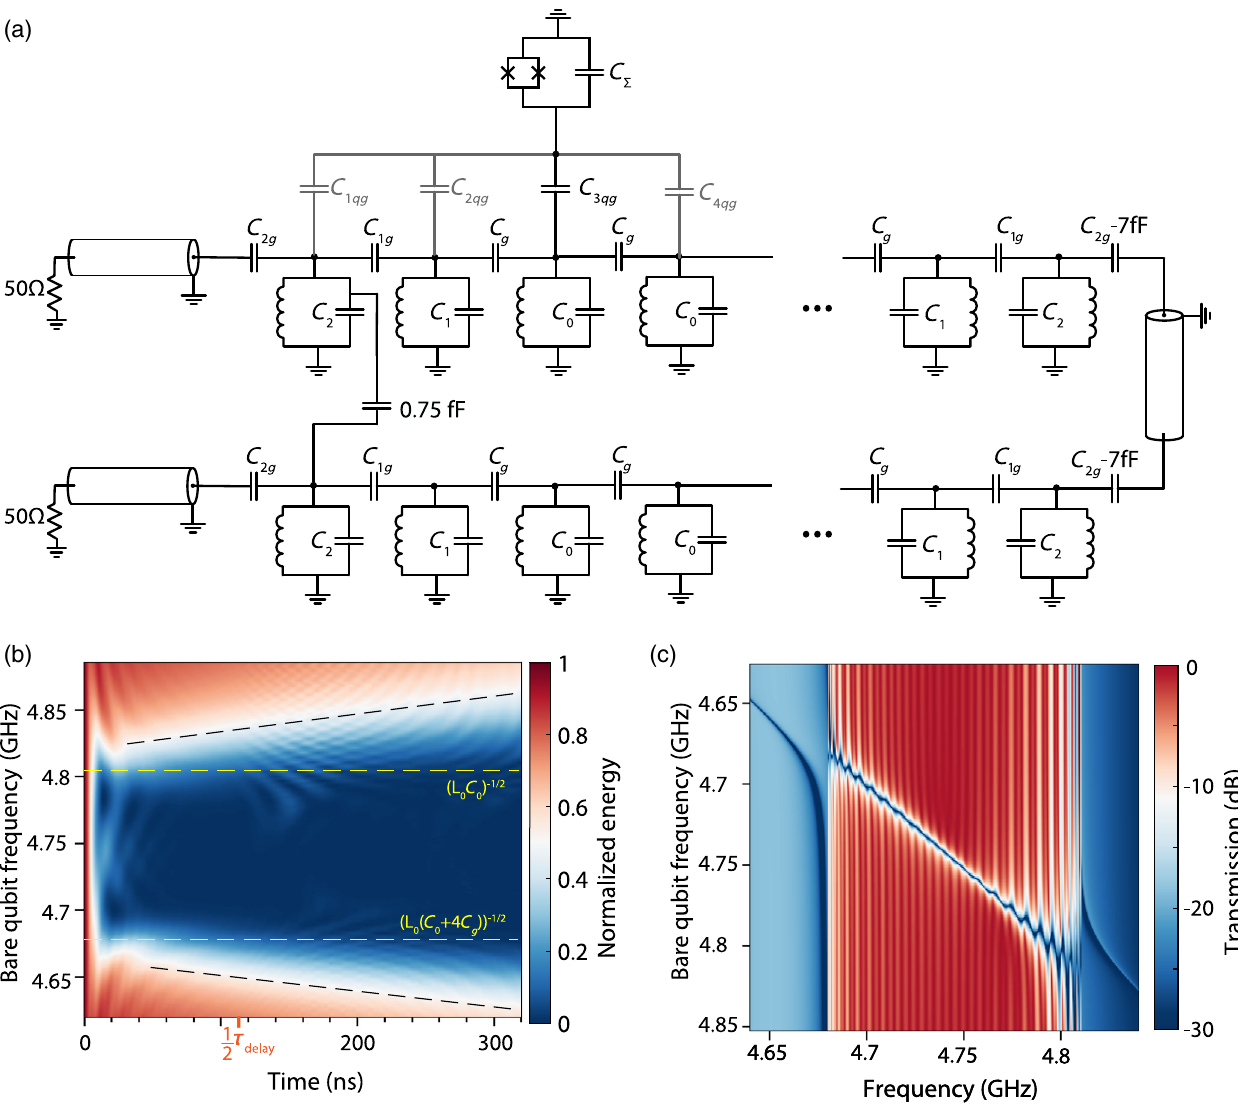
FIG. 10. (a) Full circuit model used in simulations. All inductors are made equivalent, with inductance L 0 . Parameters are further discussed in the text. (b) Simulation of Fig. 3(b) dataset. The intensity plot is of energy in the faux-qubit resonator normalized by the initial energy; this simulated time-dependent normalized energy corresponds directly to the qubit ’ s excited-state population measurements in Fig. 3(b). Simulation parameters are described in the text. Band edges are highlighted in dashed yellow lines, while dashed black lines are guides to the eye. (c) Simulation of Fig. 2(d) dataset. Circuit model and simulation parameters are described in the text. Simulations are done with the aid of the Microwave Office software